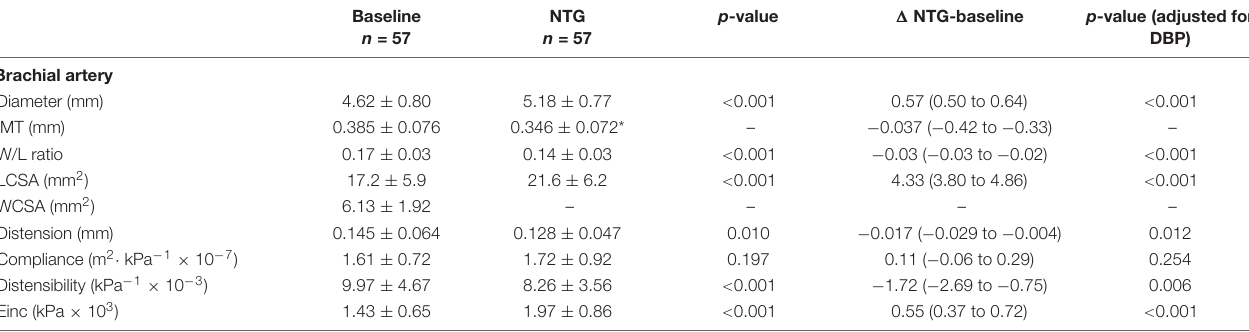
TABLE 4 | Brachial artery changes according to nitroglycerin administration.